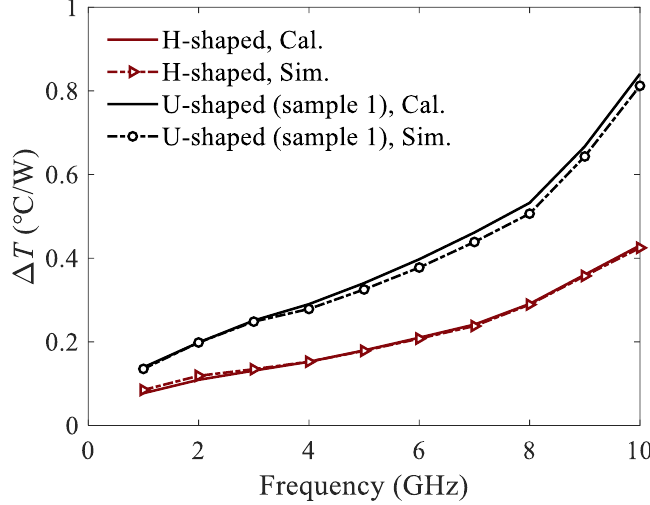
Figure 12. Temperature rises per watt of the corrugated SWTLs.